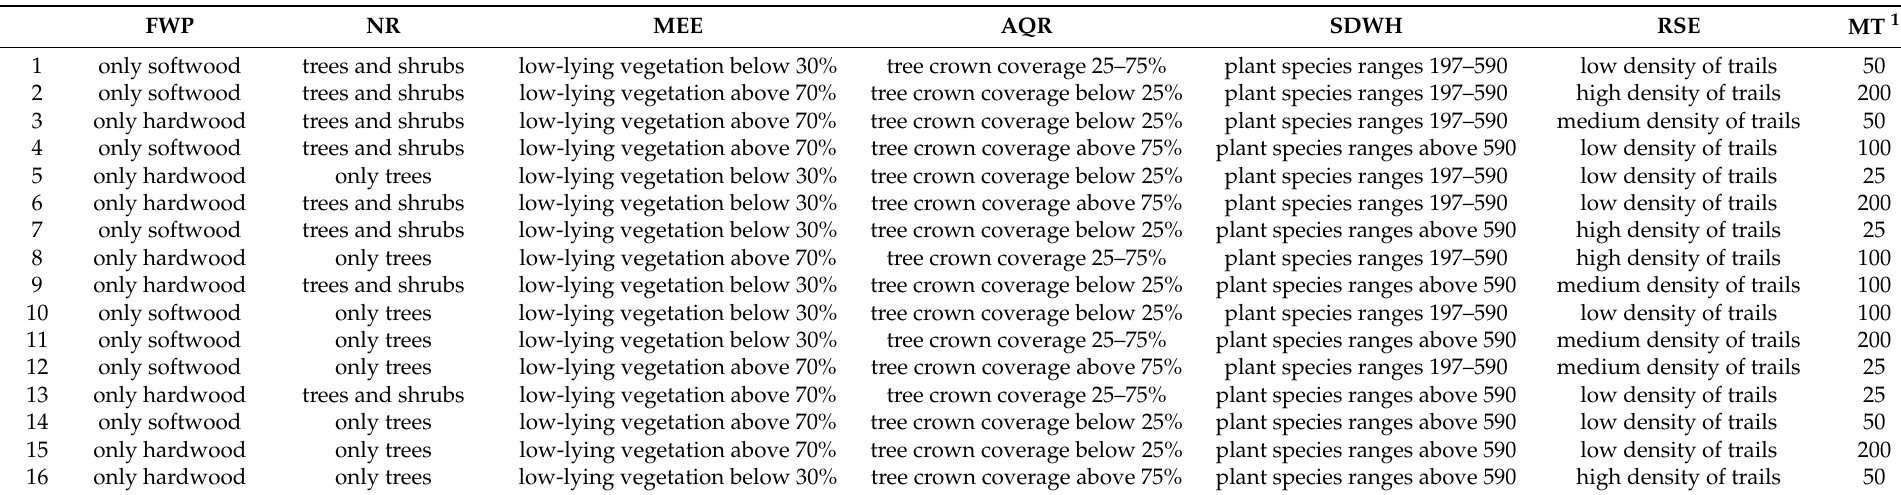
Table 5. Card List of 16 alternatives of urban forest ecosystem